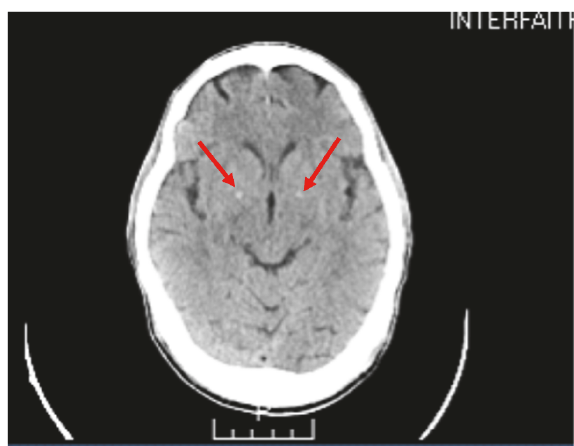
Figure 2: CT scan without contrast showing bilateral basal ganglia